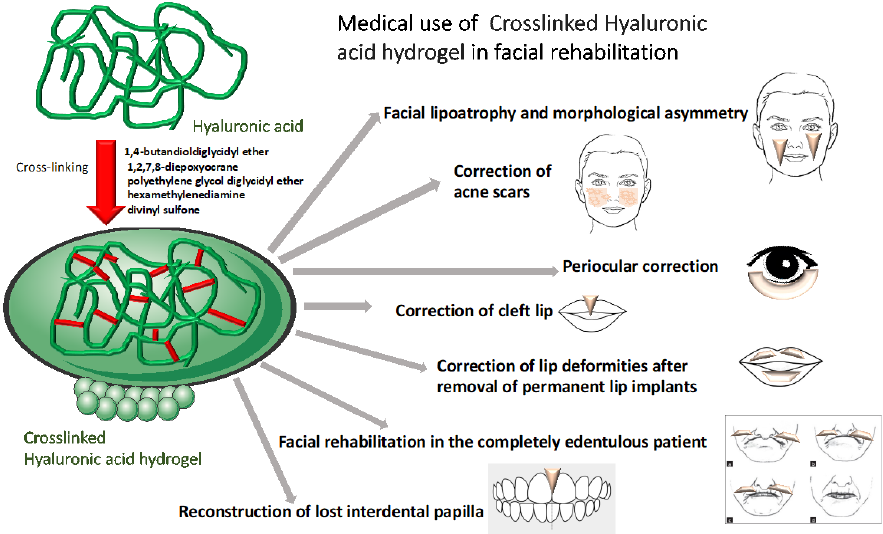
Figure 1. Possible indications of HAF for facial rehabilitation.